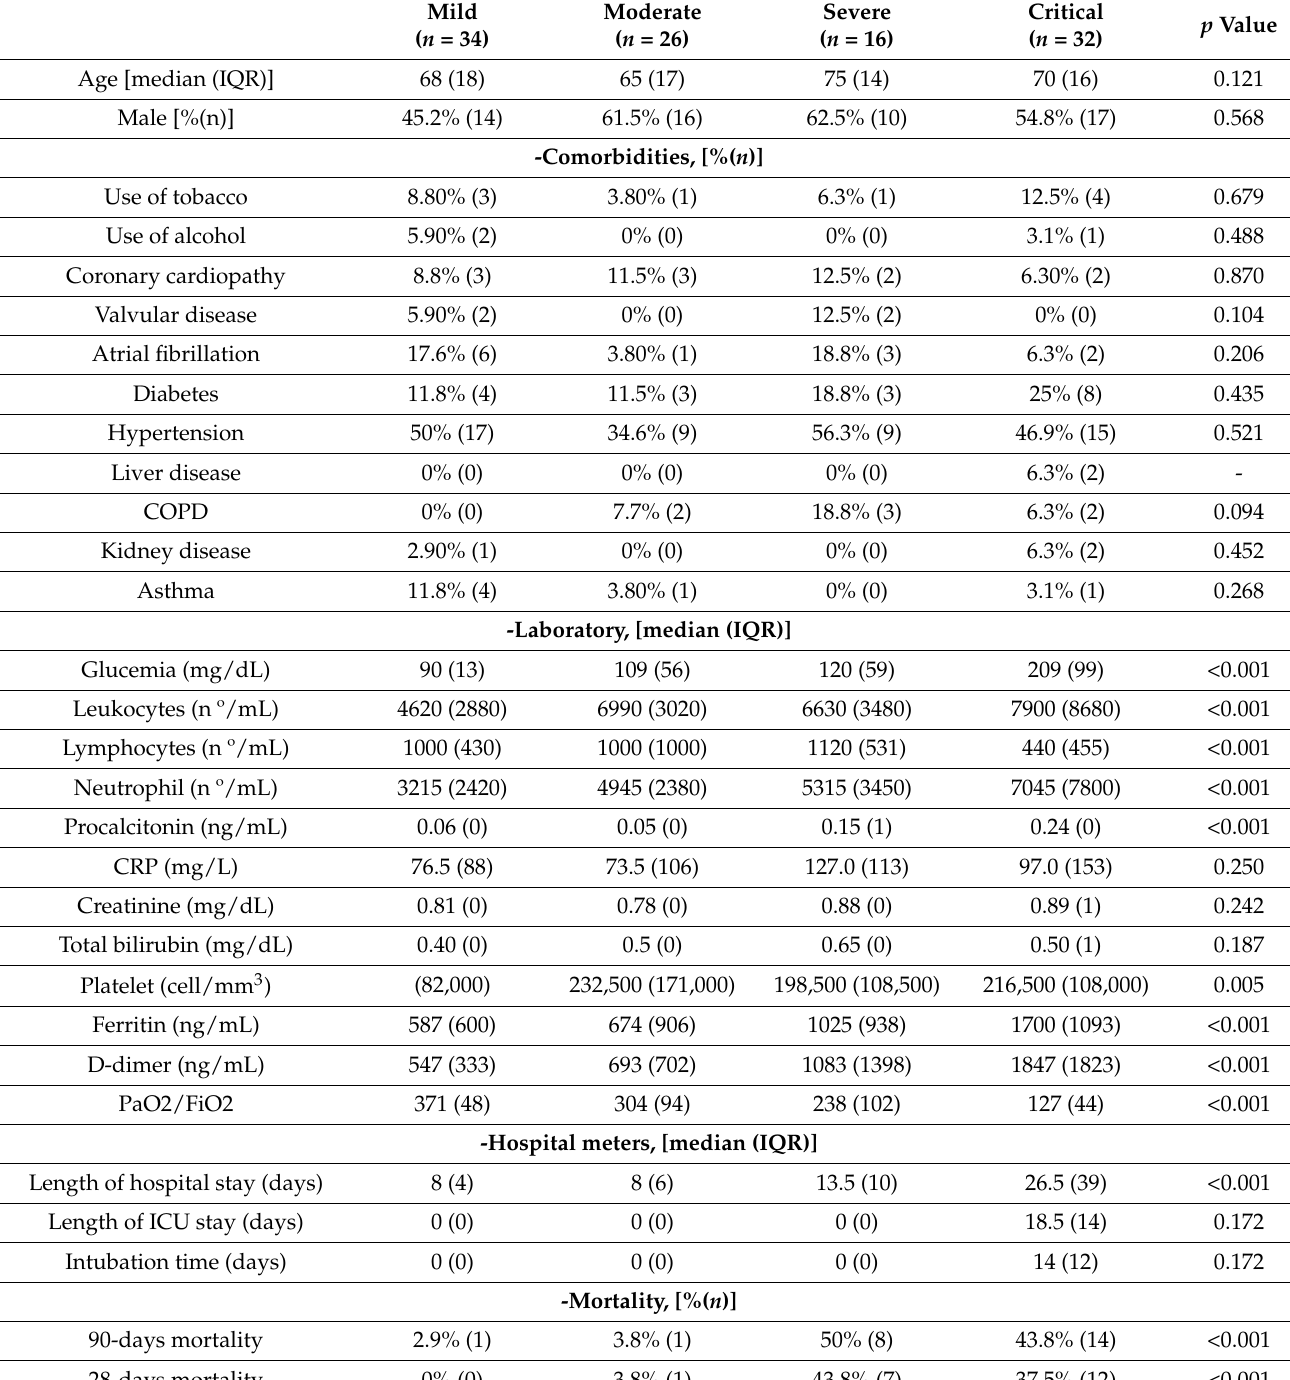
Table 1. Clinical characteristics of the